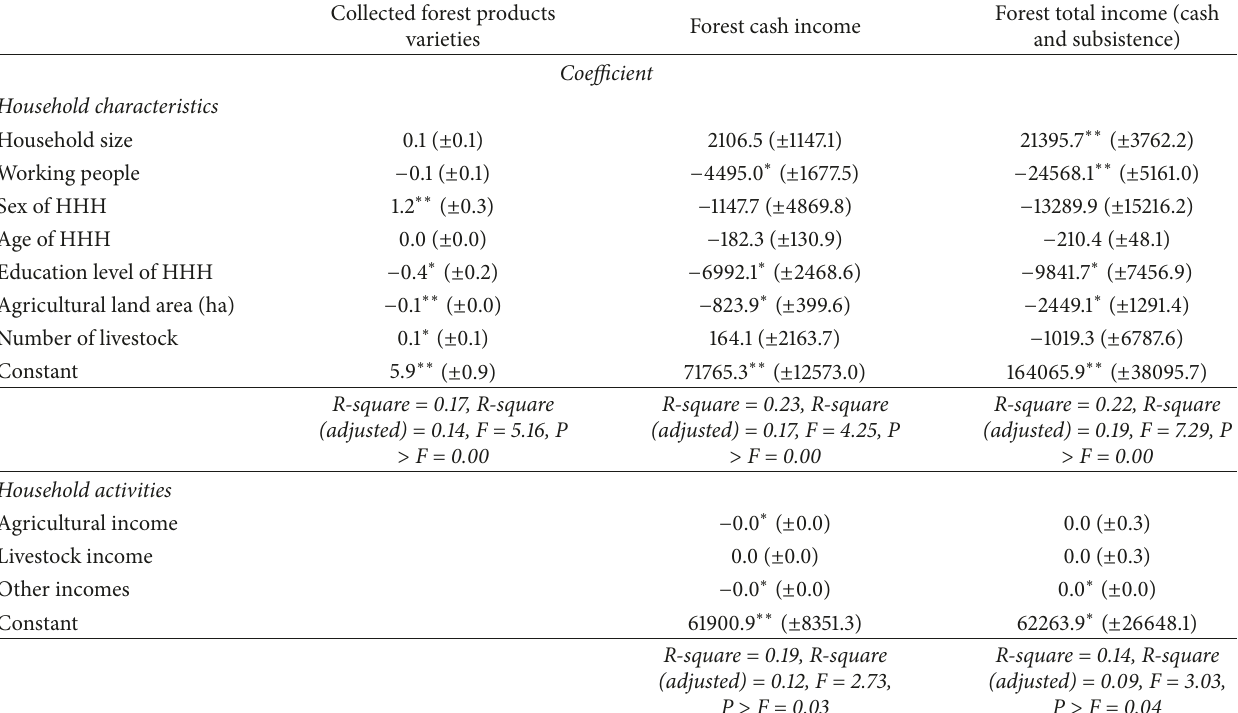
Table 5: OLS regression model of collected forest products varieties for both subsistence and income of the forest products against the household characteristics and household income activities ( 𝑛 = 207